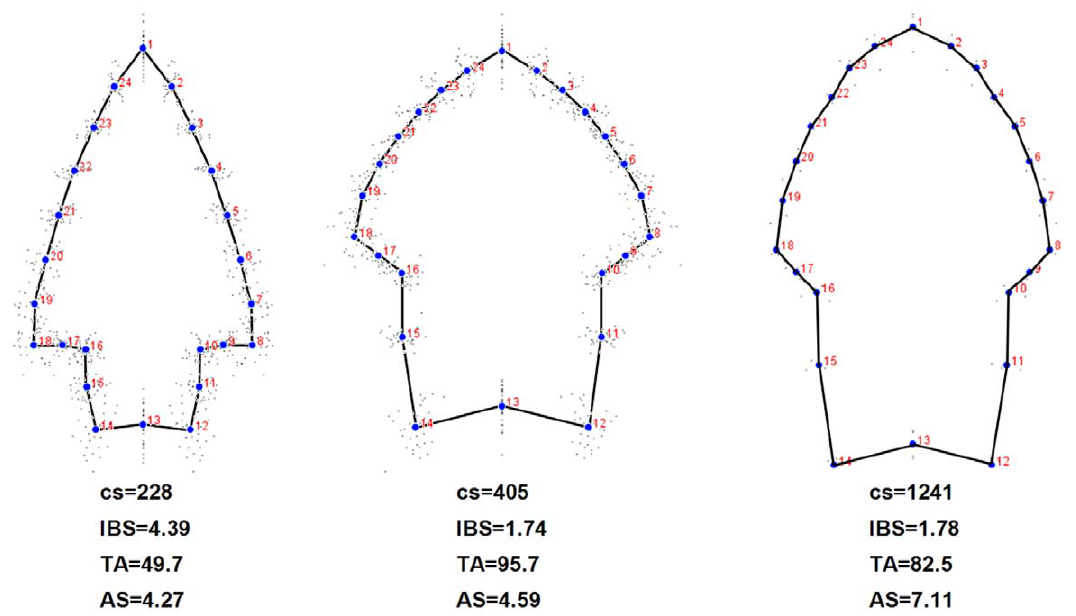
Figure 4. Consensus configurations. Consensus for the Type 1 (left), 2 (center), and 3 (right) groupings derived from the composite PC analyses presented on Fig. 3. Mean values of size (cs), blade-stem length ratio (IBS), tip-angle (TA), and asymmetry (AS) are presented.